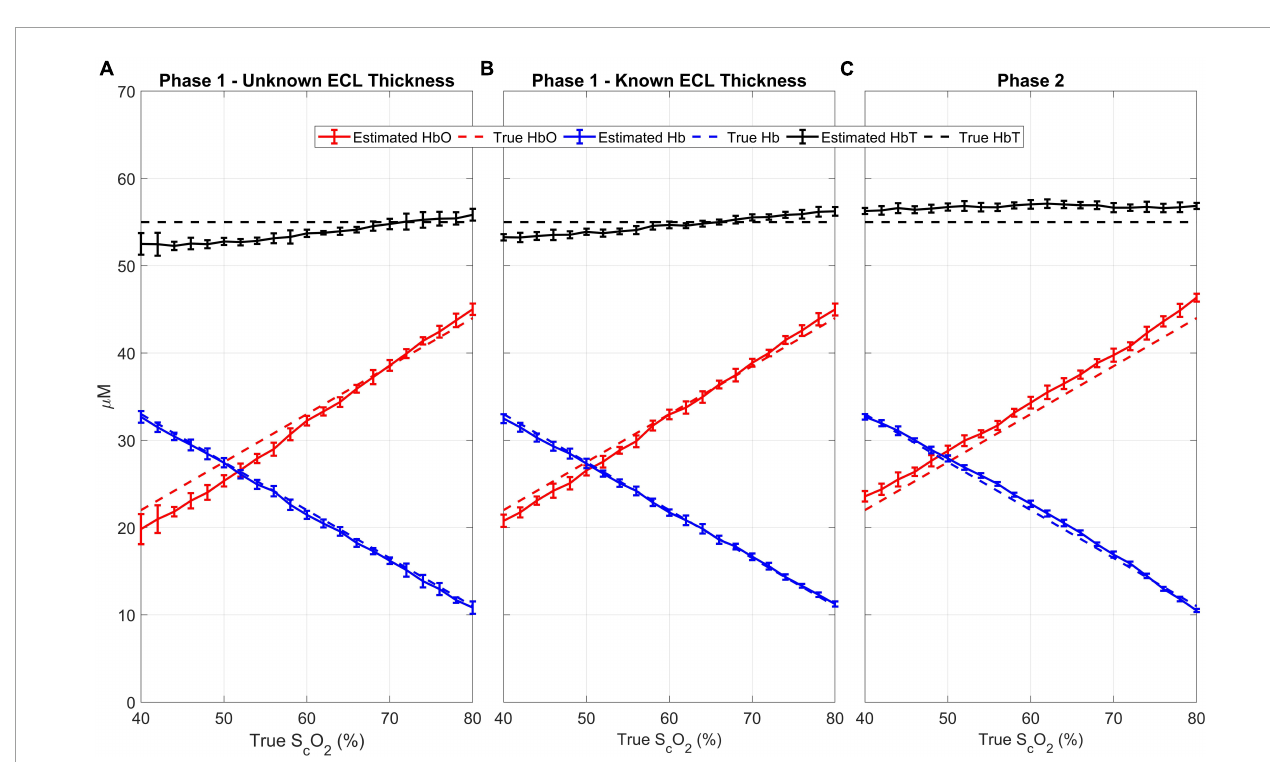
of the current report show that the algorithm can estimate adult cerebral oxygen saturation and total hemoglobin concentration with high accuracy. Although it takes 5.2 min to analyze a full trNIRS spectrum with Phase 1, this phase is only needed once